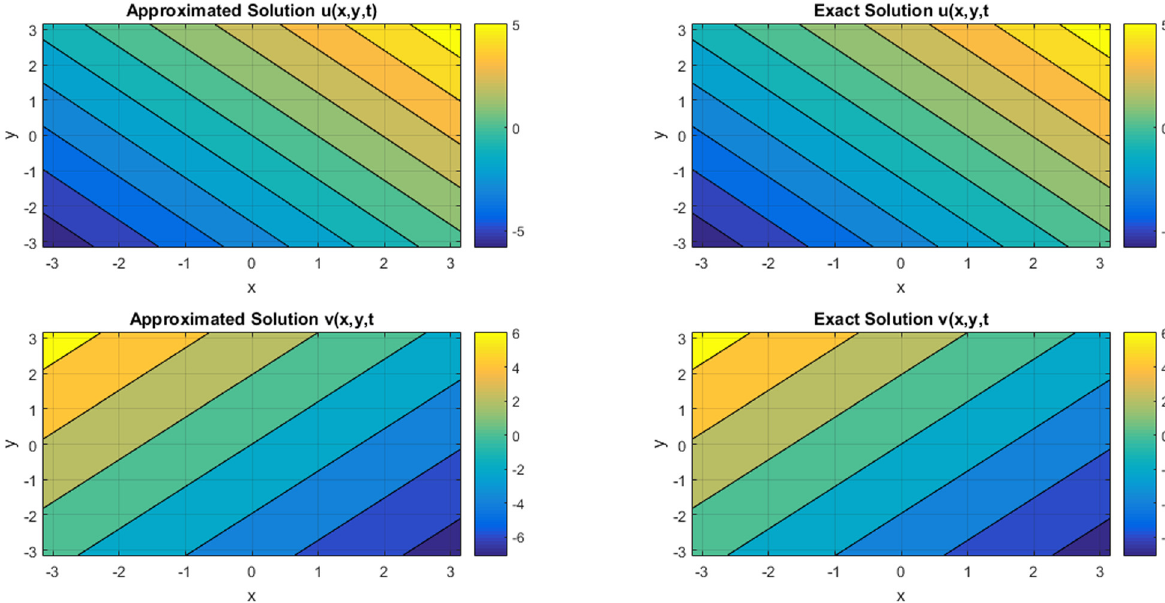
Figure 4: Contour plot for comparison of approximated and exact solutions of ϕ and ψ components at t = 0.1 for N = 11 regarding Example